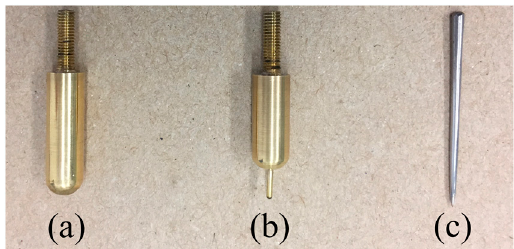
Figure 14. High potential electrodes (brass) used in non-uniform electric field experiments: ( a ) rod electrode (R = 6 mm); ( b ) rod electrode (R = 1 mm); ( c ) needle electrode.